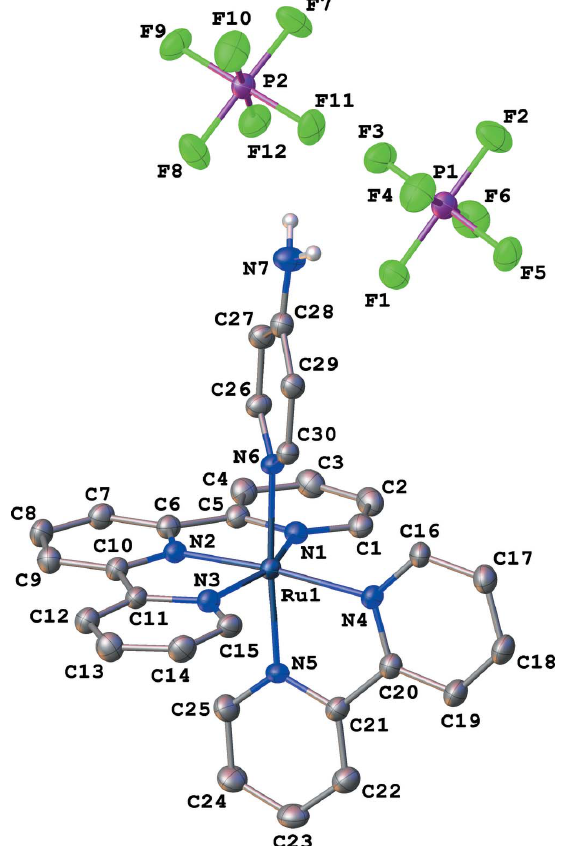
Figure 2 Anisotropic displacement ellipsoid plot drawn at the 50% probability level. Only the major component of the disordered PF 6 (cid:2) anion and only the NH 2 hydrogen atoms are displayed. To one anion the N—H (cid:3)(cid:3)(cid:3) F hydrogen bonding is bifurcated (see Table 2 for additional metrical details).